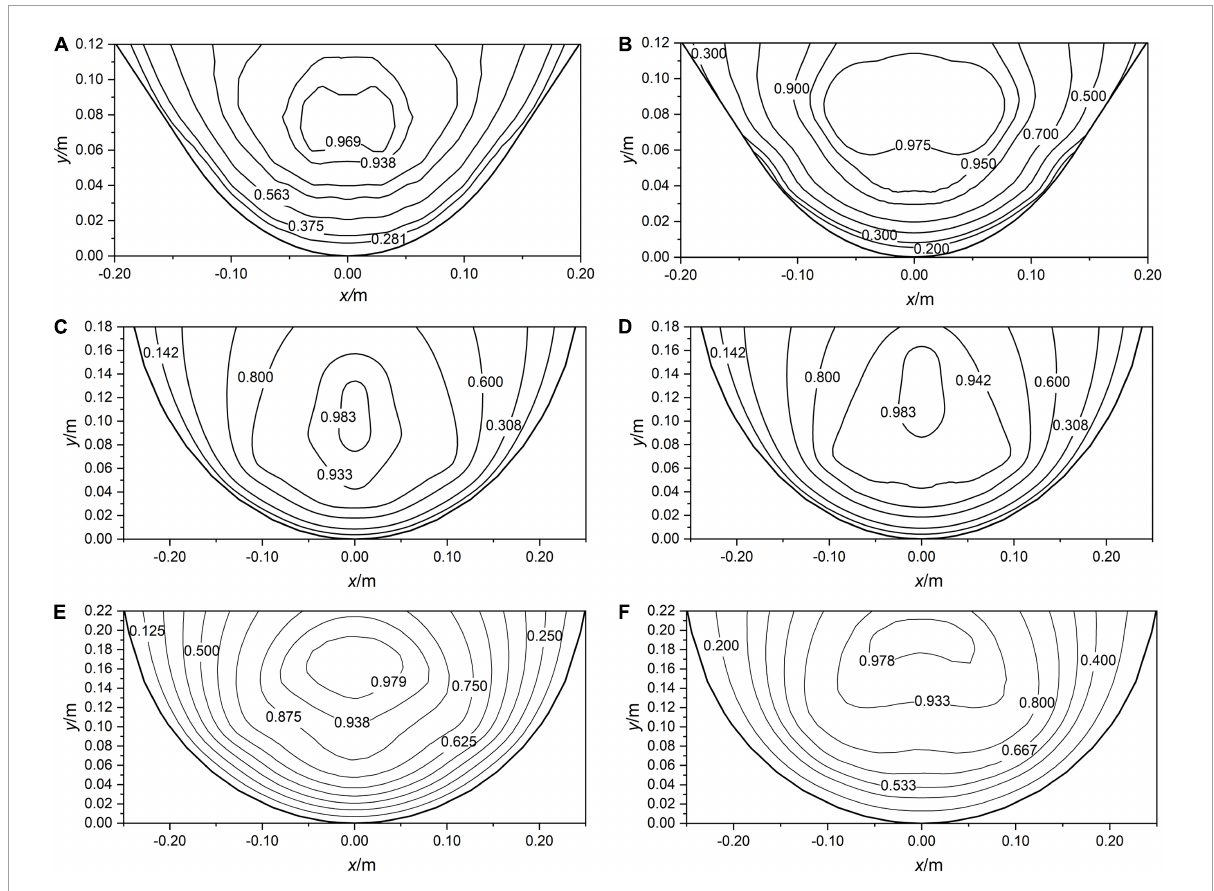
FIGURE4 The contour distribution of velocity normalized in channels under M1 (A) , M2 (B) , N1 (C) , N2 (D) , T1 (E) , T2 (F) .